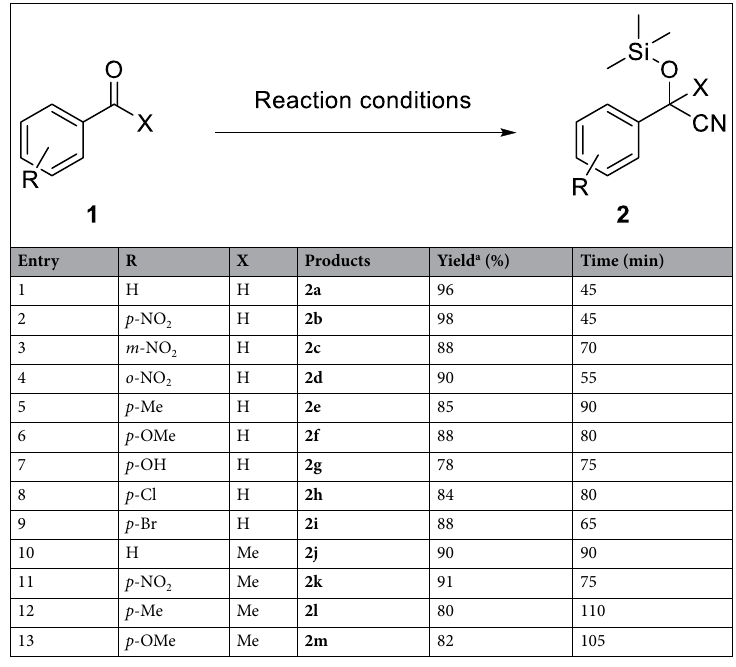
Table 2. CYSR of different substituted carbonyl compounds with TMSCN with catalyst TBA-PW 11 . Reaction conditions: aldehyde (1 mmol), TMSCN (2 mmol), 2 mol% of TBA-PW 11 at 65 °C at S.F. a Isolated